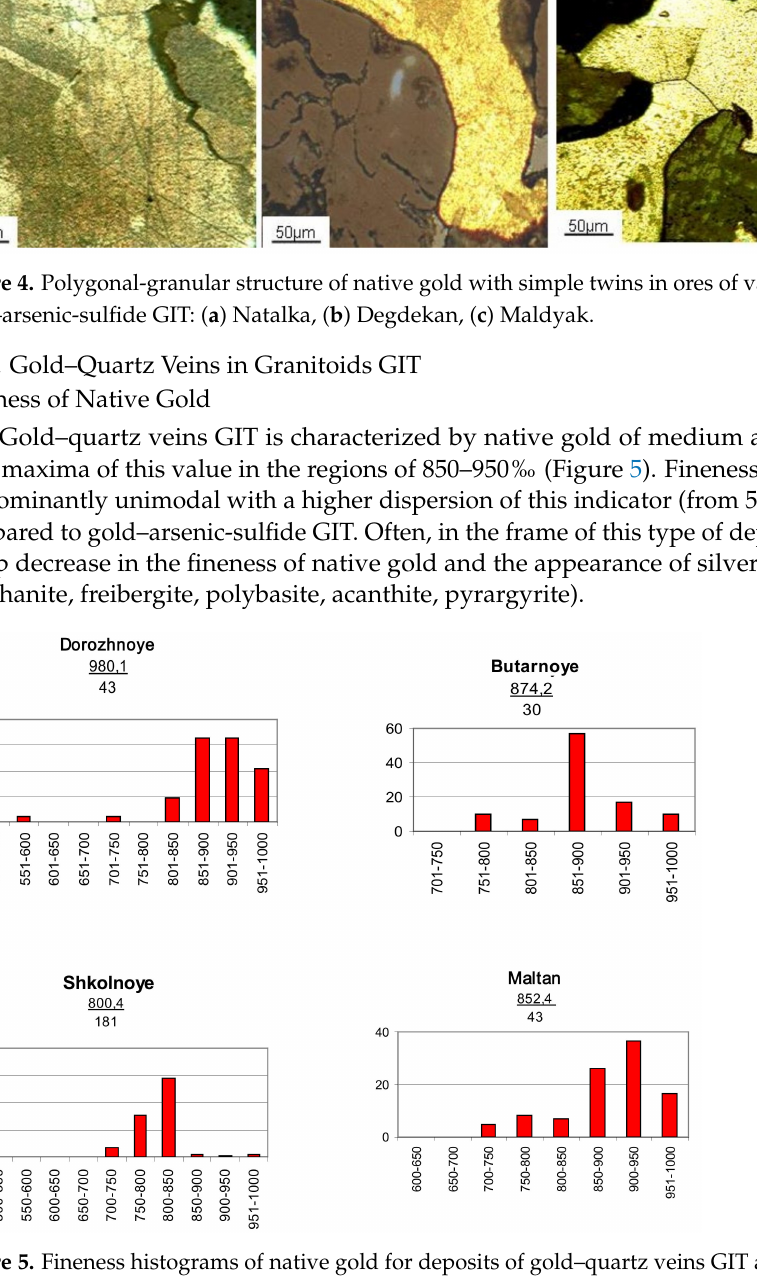
Figure 5. Fineness histograms of native gold for deposits of gold–quartz veins GIT along the abscissa axis—frequency of occurrence, %; along the x -axis, fineness intervals, ‰; in the numerator—fineness, ‰, in the denominator—the number of